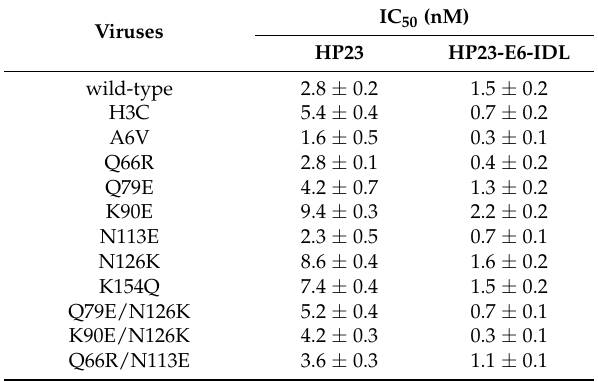
Table 2. Inhibitory activities of HP23 and HP23-E6-IDL against HIV-1 T2635-resistant strains.